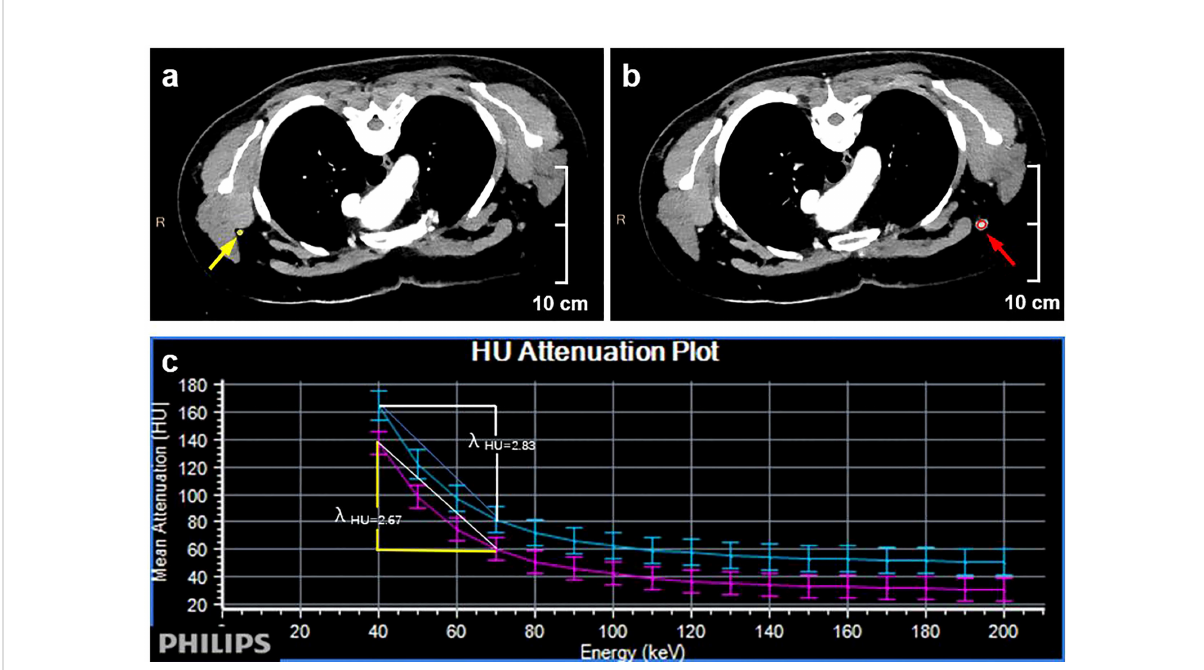
FIGURE 4 Quantitative dual-layer spectral CT parameter measurement of the same patient as in Figure 3. (A) The ovoid area of interest (yellow) is shown on a 70 keV enhanced image of a nonmetastatic lymph node. (B) The oval-shaped region of interest (red) is shown on the 70 keV enhanced image of the metastatic lymph node. (C) The graph shows that the value of l Hu is higher in the metastatic lymph node than in the nonmetastatic lymph node (2.83